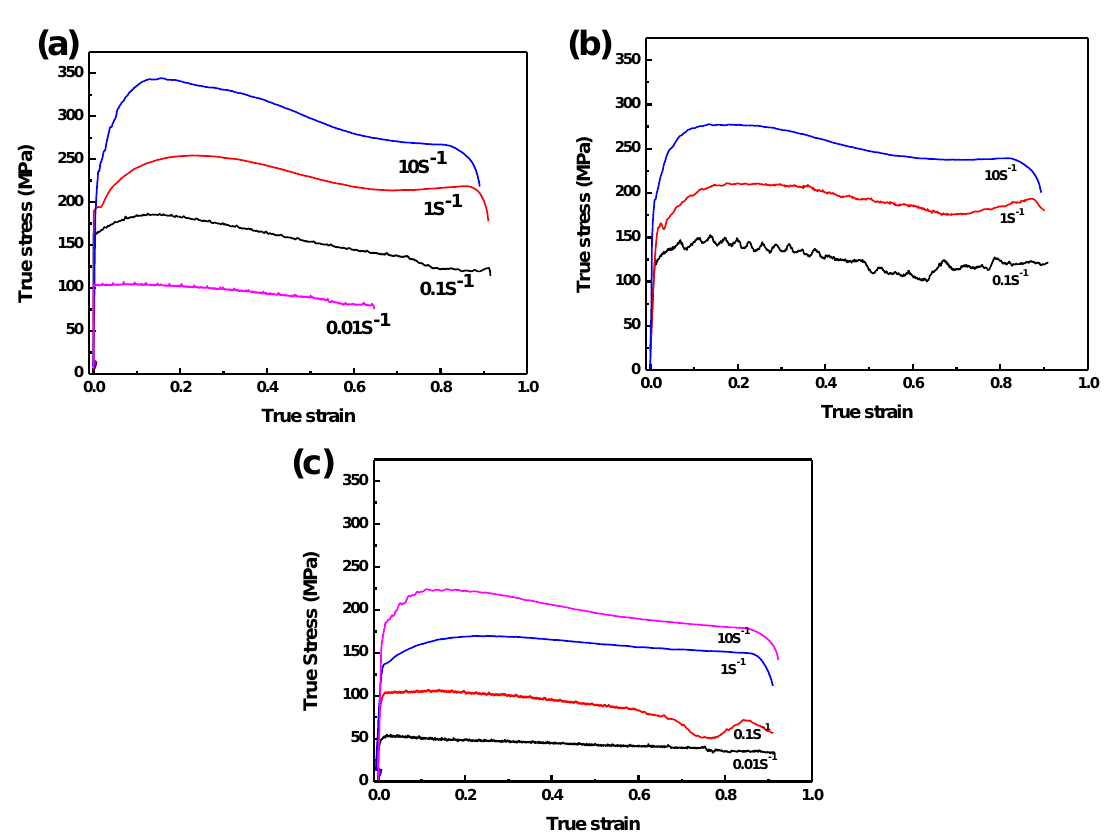
Figure 1. Stress-stain ( σ - ε ) curves for borated stainless steel (BSS) at different temperatures ( a ) 1000 °C; ( b ) 1050 °C; ( c ) 1100 °C and various strain rates.